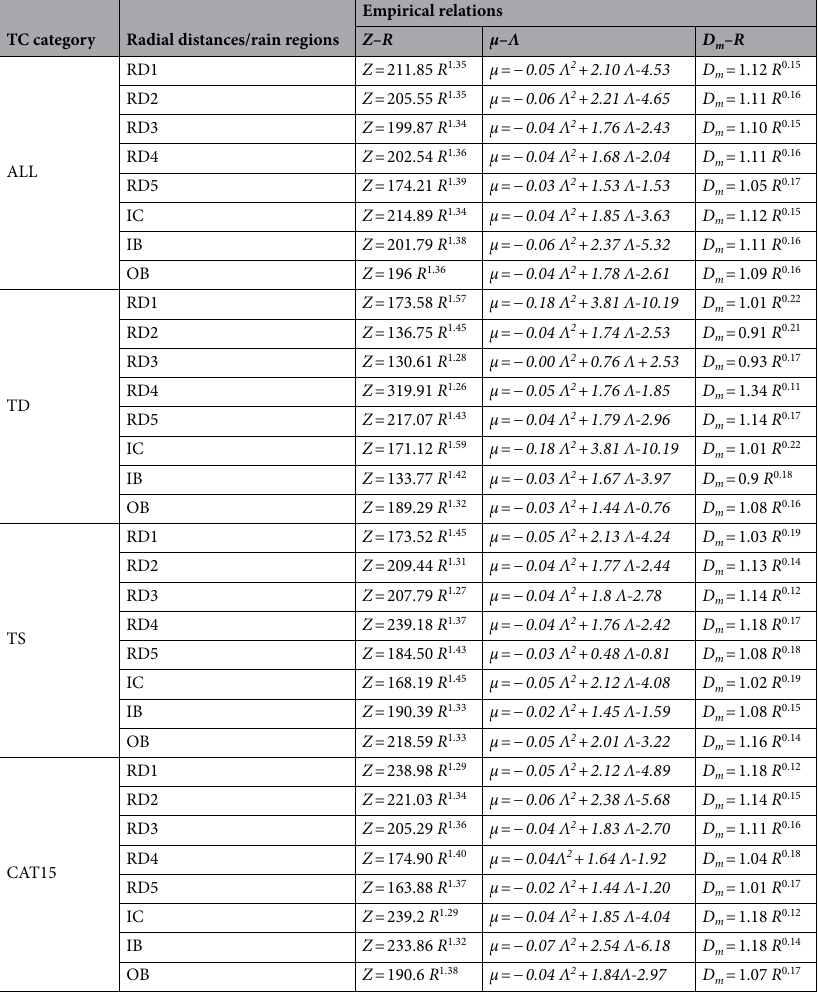
Table 1. Rainfall estimation relations. Radar reflectivity–rainfall rate ( Z – R ), shape–slope ( μ – Λ ), and mass- weighted mean diameter–rainfall rate ( D m – R ) relations for different radial distances and rain regions of NWP